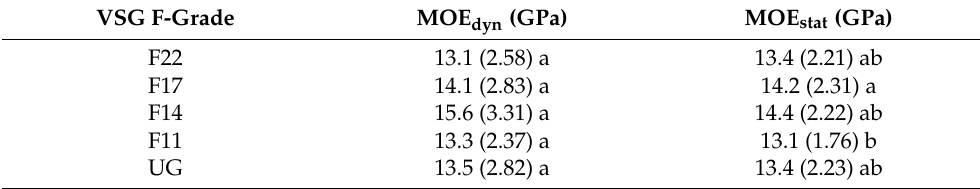
Table 6. Actual stiffness (MOE dyn and MOE stat ) of dressed boards ( n = 268) classified by the Visual Stress Grading (VSG) grades. Comparisons among grades are made separately for MOE dyn and for MOE stat , respectively, and different letters within columns indicate significant differences. Board grades are as described in Table